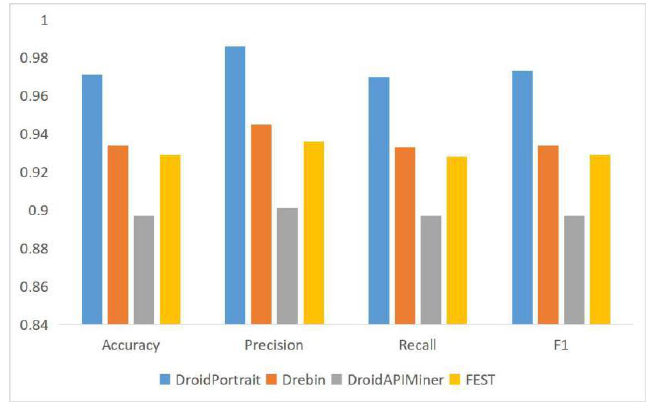
Figure 12. Performance comparison during detecting Android malware from unknown Android app dataset.